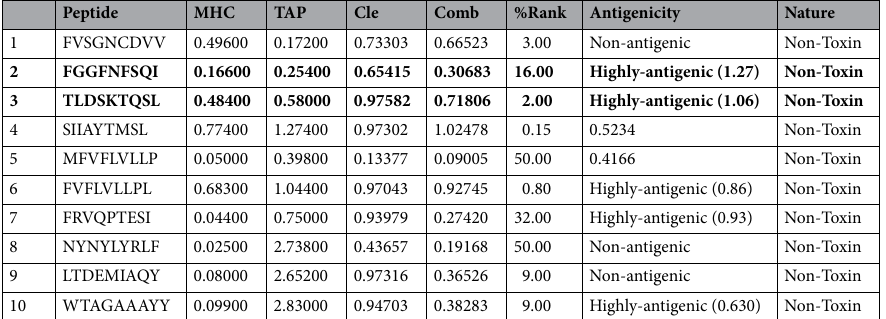
Table 2. Optimization of CTL epitopes with immunological parameters for MHC binding, transporter associated with antigen processing (TAP) affinity, C-terminal cleavage efficiency, combinatorial rank, antigenicity, and non-toxic nature